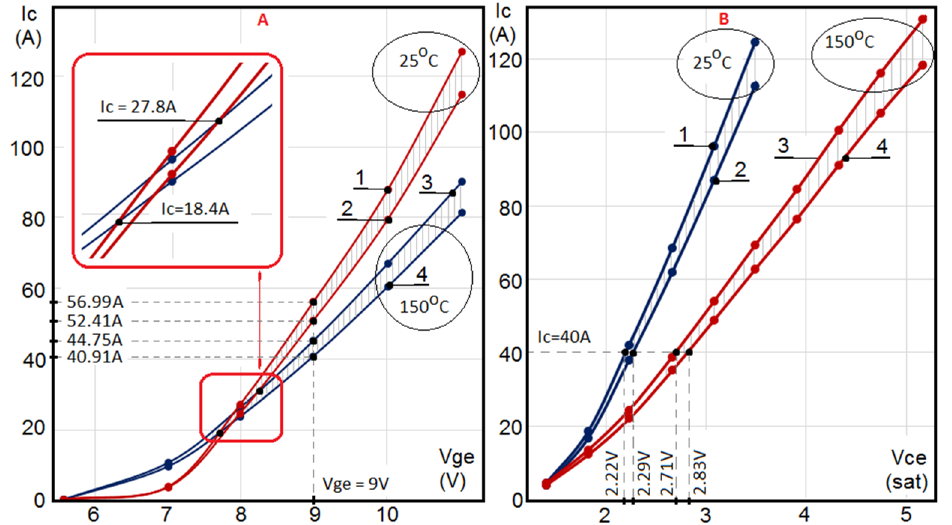
Figure 4. ( A ) Transconductance (dynamic) characteristics at nominal 25 °C (graphic 1 maximum and 2 minimum) and maximum 150 °C (graphic 3 maximum and 4 minimum) temperatures. ( B ) Output (static) characteristics at nominal 25 °C (graphic 1 maximum and 2 minimum) and maximum 150 °C (graphic 3 maximum and 4 minimum) temperatures.